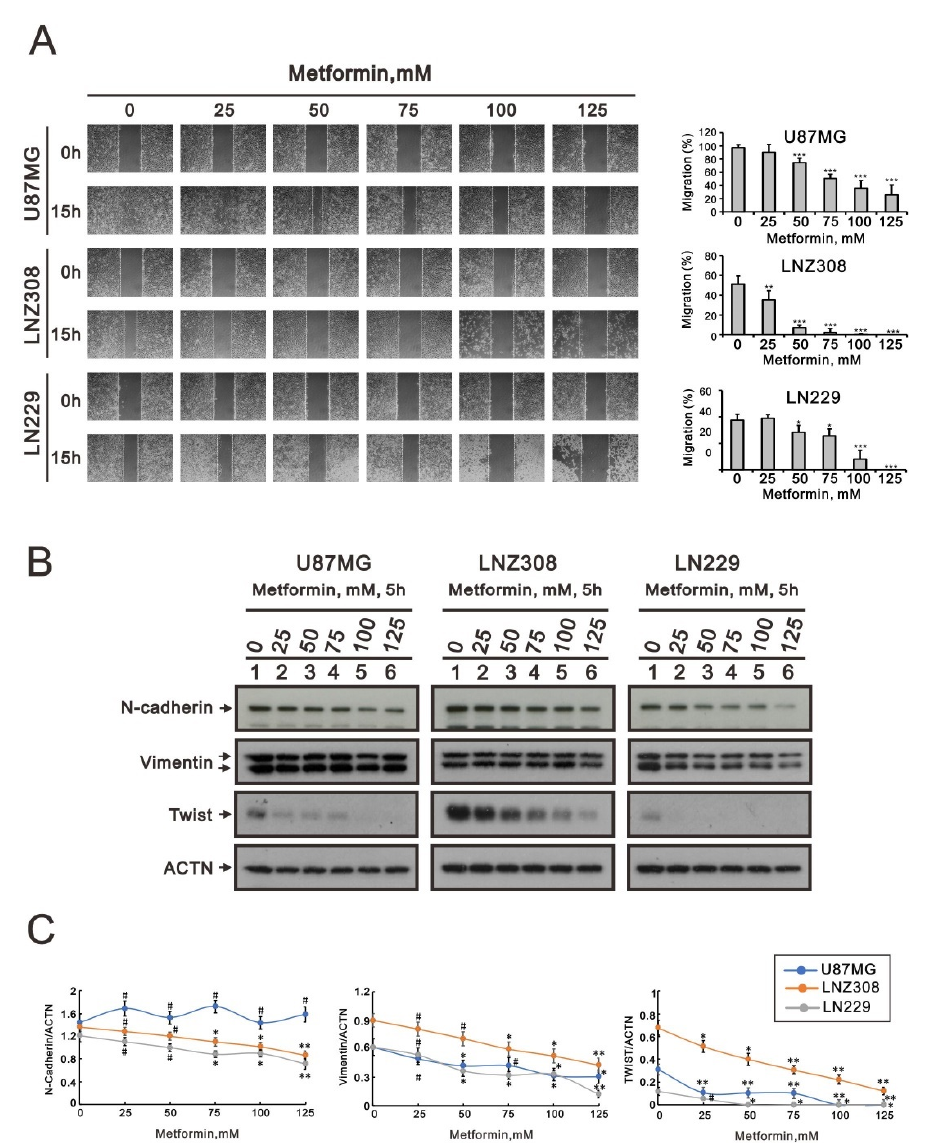
Figure 3. The effects of metformin on cell migration and EMT in GBM cell lines. ( A ) U87MG, LNZ308, and LN229 cells were treated with the indicated metformin concentrations. After 15 h, the cell migration was measured; * p < 0.05 and *** p < 0.001. ( B ) U87MG, LNZ308, and LN229 cells were treated with the indicated metformin concentrations for 5 h. Cell lysates were subjected to Western blot analysis using antibodies against the indicated proteins; ACTN was used as the protein-loading control. The protein bands were quantified through pixel density scanning and evaluated using ImageJ, version 1.44a (http://imagej.nih.gov/ij/) (accessed on 15 July 2022). ( C ) The ratios of N-cadherin/ACTN, Vimentin/ACTN, and TWIST/ACTN were plotted in the U87MG, LNZ308, and LN229 cells. The results are representative of three independent experiments. # p > 0.05, * p < 0.05, ** p < 0.01, and *** p < 0.001.